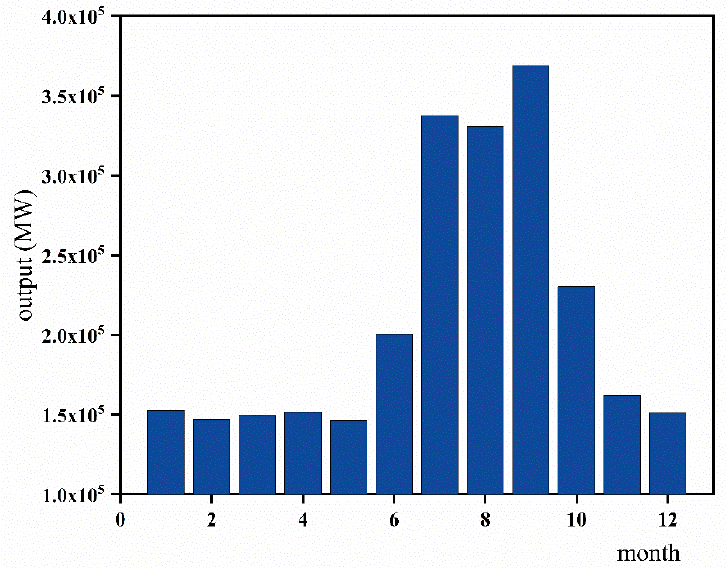
Figure 5. Output of the cascade hydropower plants.